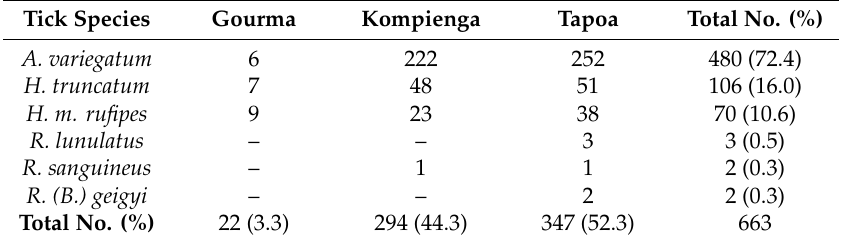
Table 2. Number of ticks collected in cattle in three provinces of eastern Burkina Faso.